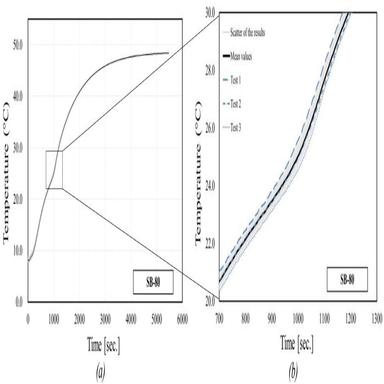
Temperature evolutions for the SB-80 RBA specimens: (a) mean value curve and scatter of the results; (b) zoom view between 700–1300 s. and 20–30 °C.